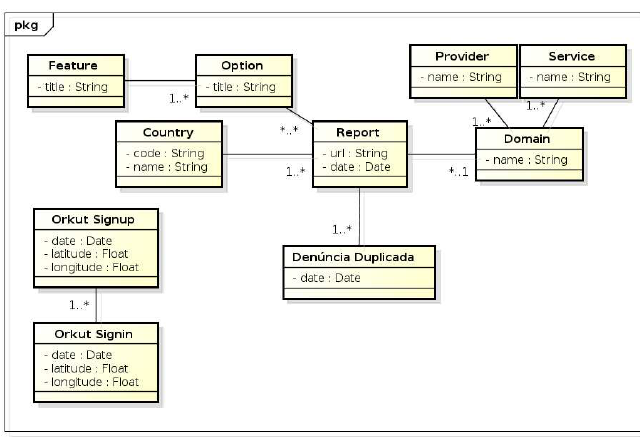
Fig. 4. Database used in the case